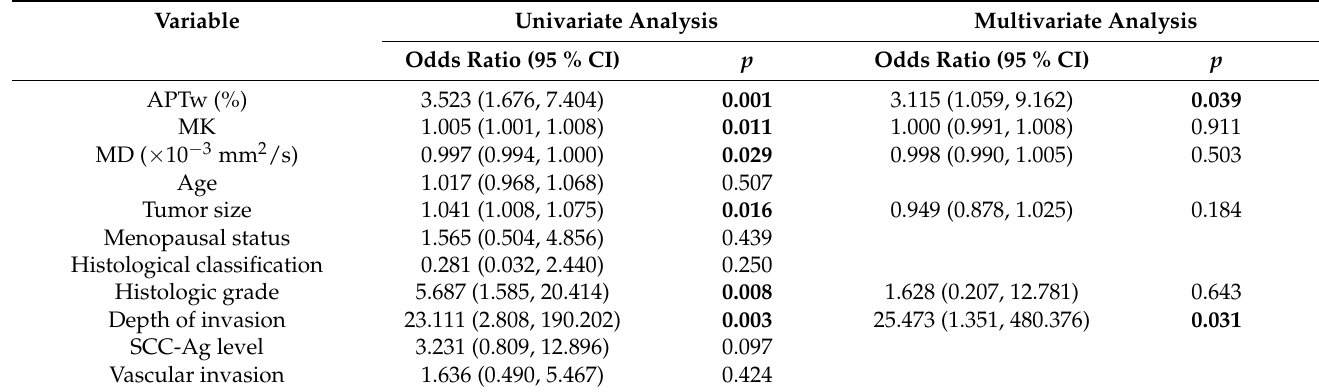
Table 3. Univariate and multivariate logistic regression analysis for LNM in cervical cancer.